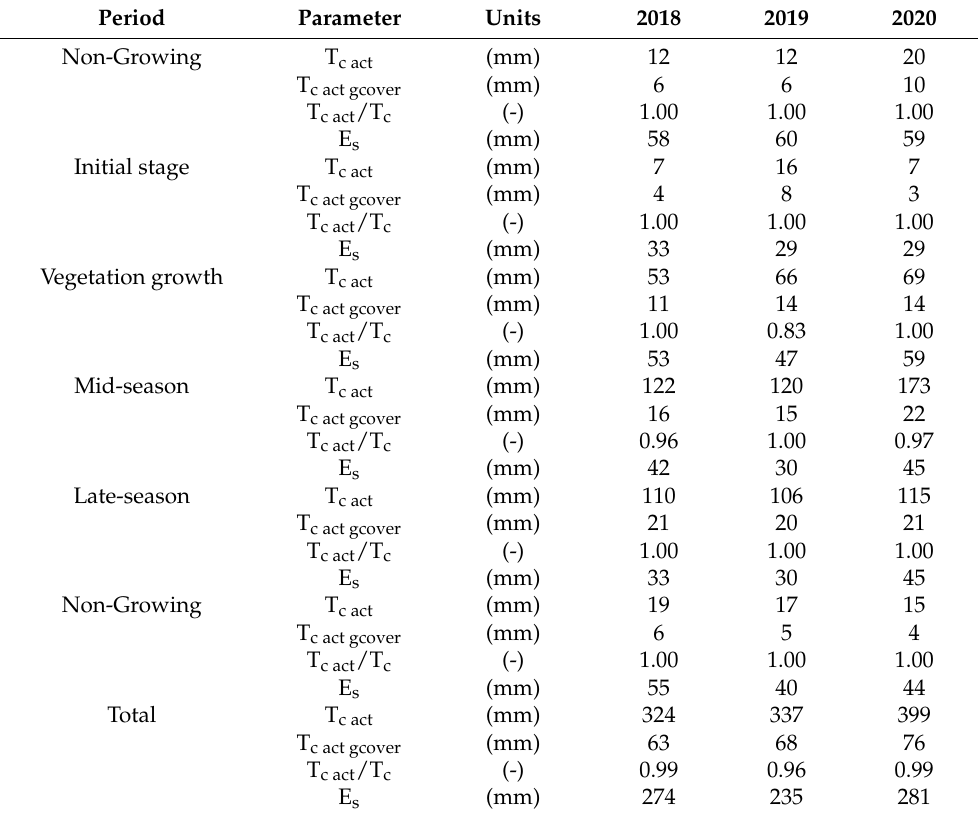
Table 11. Evapotranspiration partitioning in the Samora Correia vineyard during the different crop